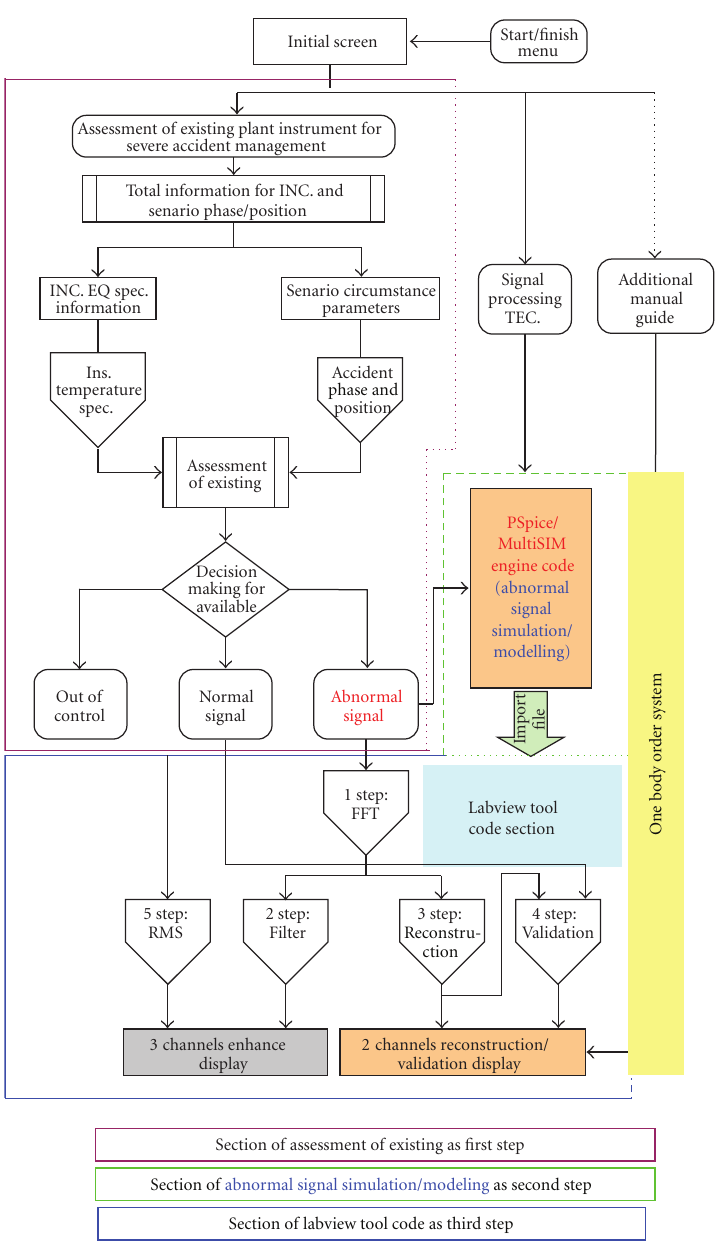
Figure 3: Flowchart of the overall design steps for the simulator as ASSA